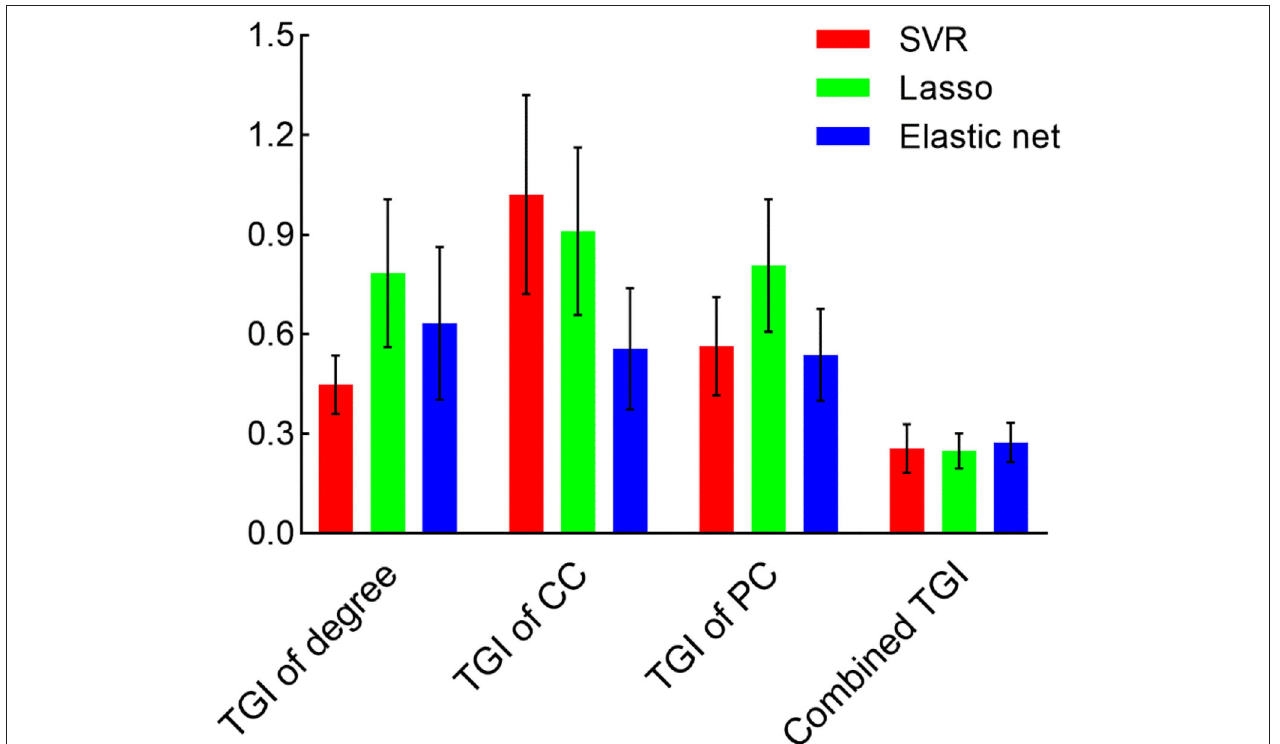
FIGURE 4 | The MSE is derived from different models and features. Bars represent the mean and SD of the MSE during the cross-validation process. CC, clustering coefficient; PC, participation